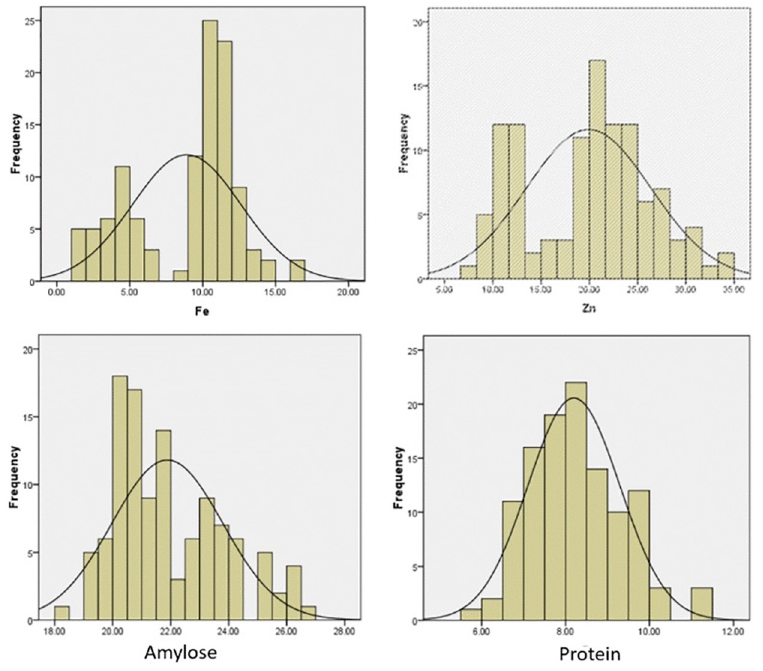
Fig 1. Frequency distribution of 113 aromatic rice germplasm for four traits.